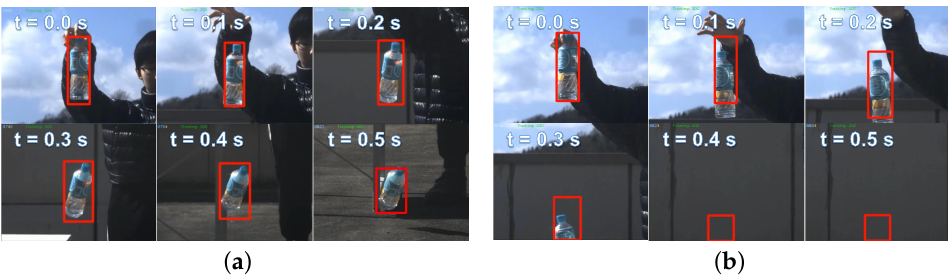
Figure 14. Tracking status of the free-fall of bottle 1 when tracking three bottles simultane- ously: ( a ) free-fall of bottle 1 based on CNN hybrid tracking and ( b ) free-fall of bottle 1 based on YOLOv4